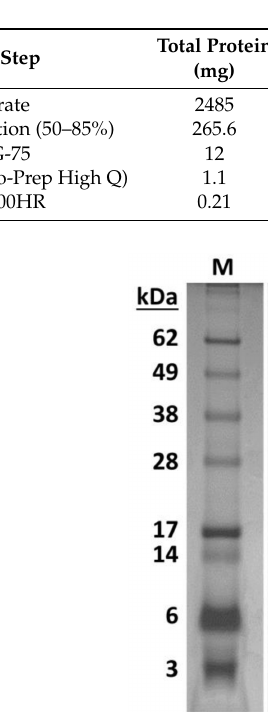
Table 1. Results of purification of the extracellular lipase from M. echinosphaera CBS 575.75.